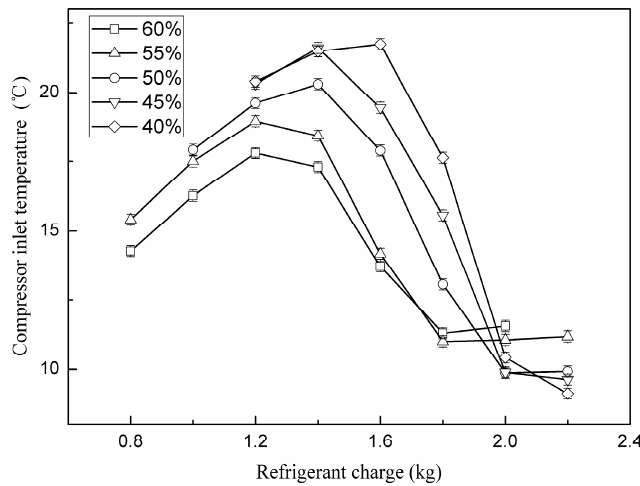
Figure 5. Variations of compressor inlet temperature with refrigerant charge and EEV opening.